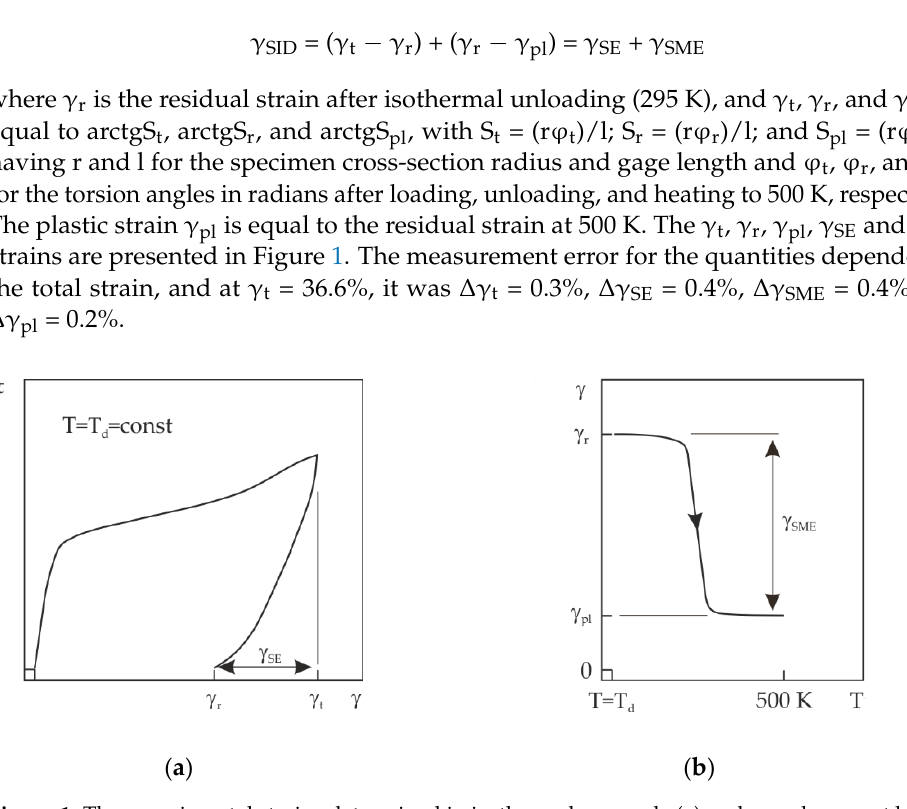
Figure 1. The experimental strains determined in isothermal τ–γ cycle ( a ) and on subsequent heating of unloaded specimen ( b ).